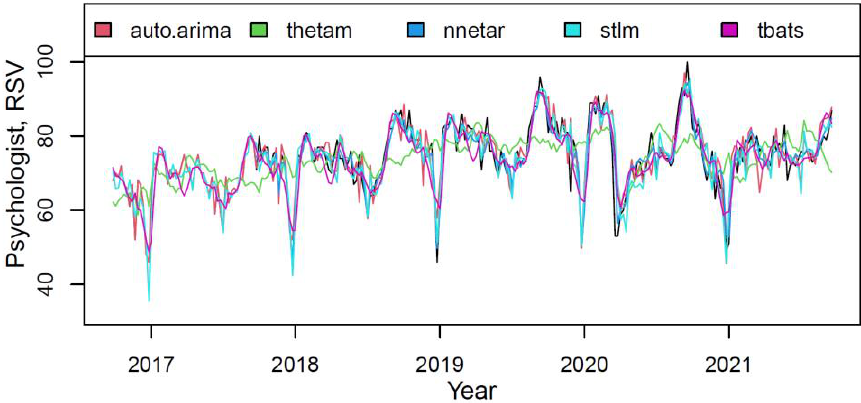
Figure 7. The actual (black) and fitted values of each component of the M3 hybrid model.